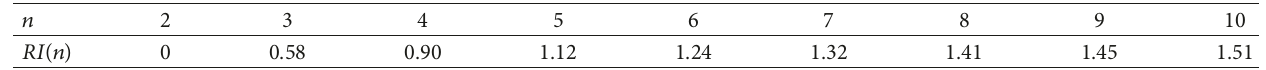
Table 1: The 𝑅𝐼(𝑛) values for 𝑛 ≤ 10